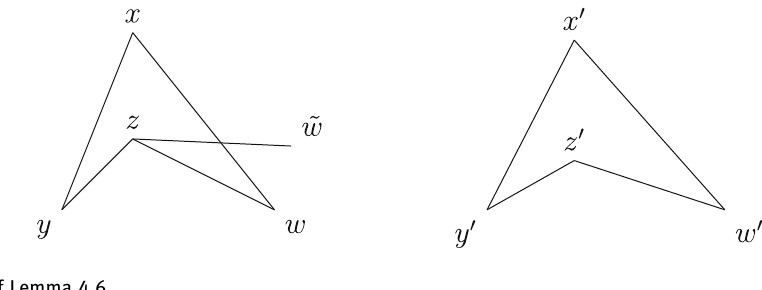
Figure 2: Proof of Lemma